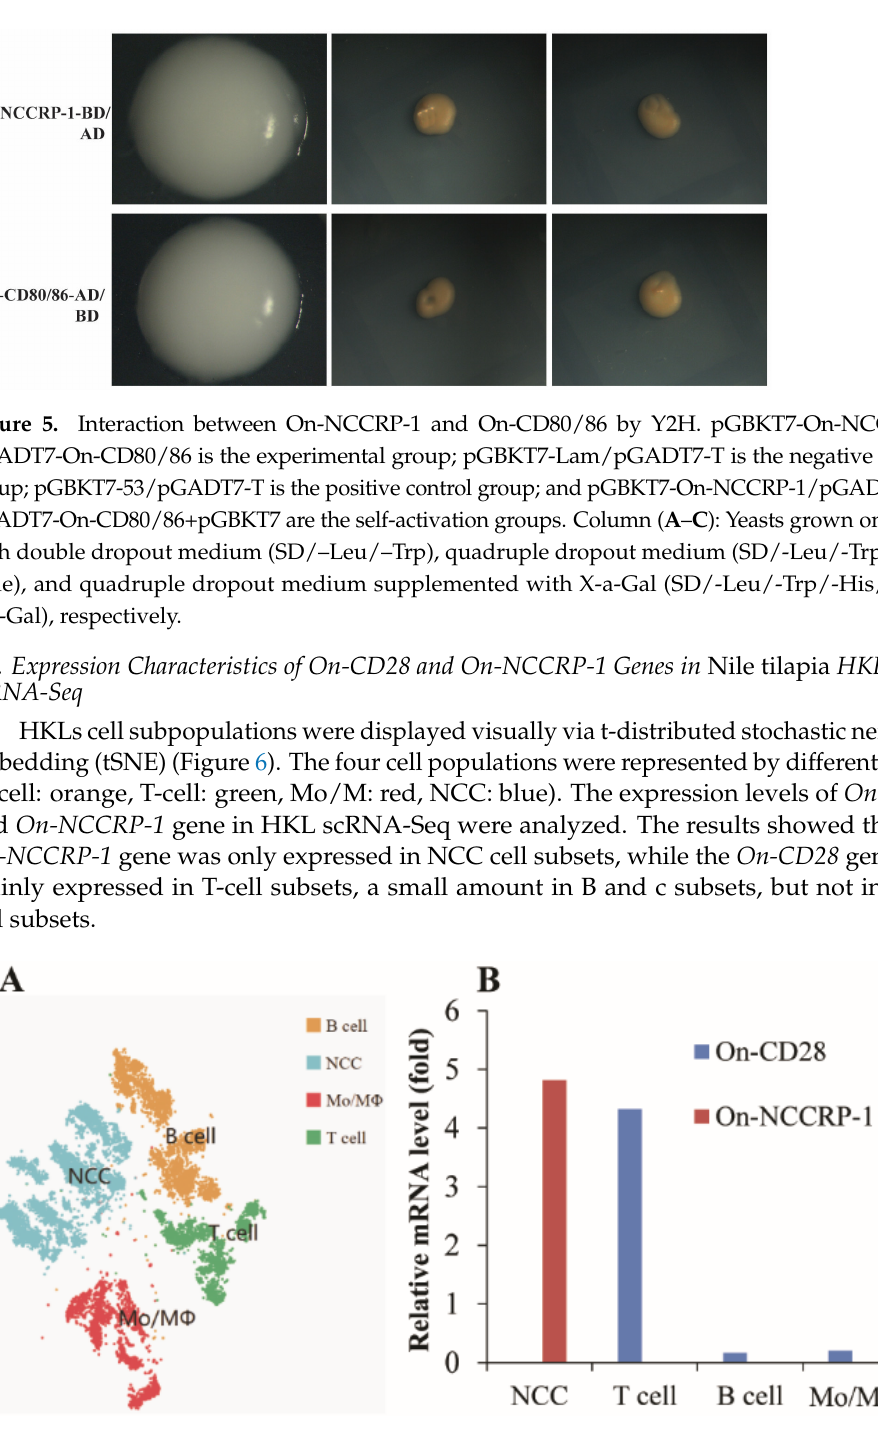
Figure 6. ( A ) The visualization of the Nile tilapia HKL population via tSNE nonlinear clustering is referred to from our previous study [25]. ( B ) Expression analysis of On-CD28 and On-NCCRP-1 in HKL subsets. HKL